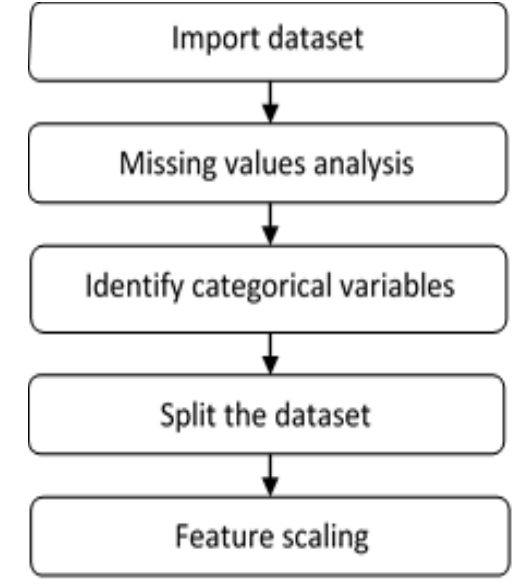
Figure 3. Steps involved in data